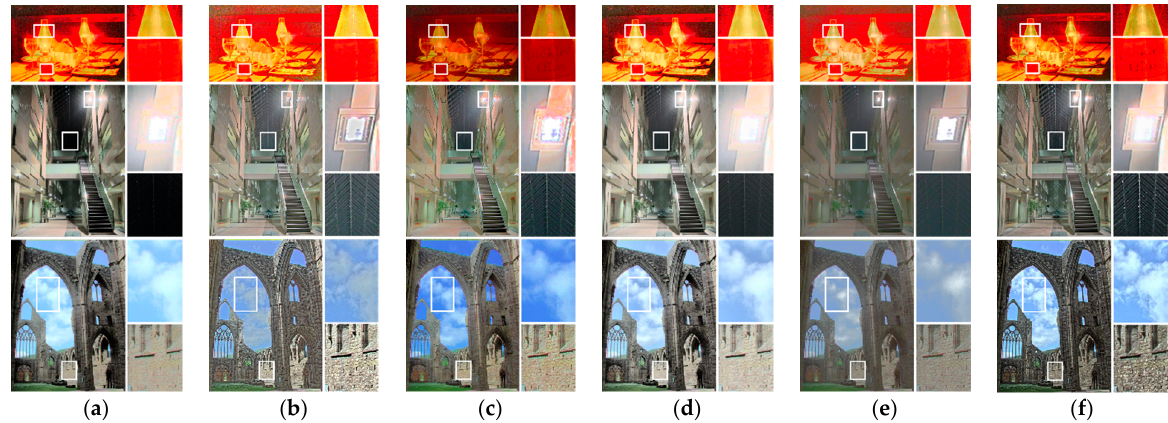
Figure 11. Comparison of the results with close-up images: ( a ) Khan et al. [9], ( b ) Gu et al. [11], ( c ) Gao et al. [28], ( d ) Ok et al. [23], ( e ) Yang et al. [21], and ( f ) the proposed method. The white rectangles indicate the areas which should be closely examined by the reader.